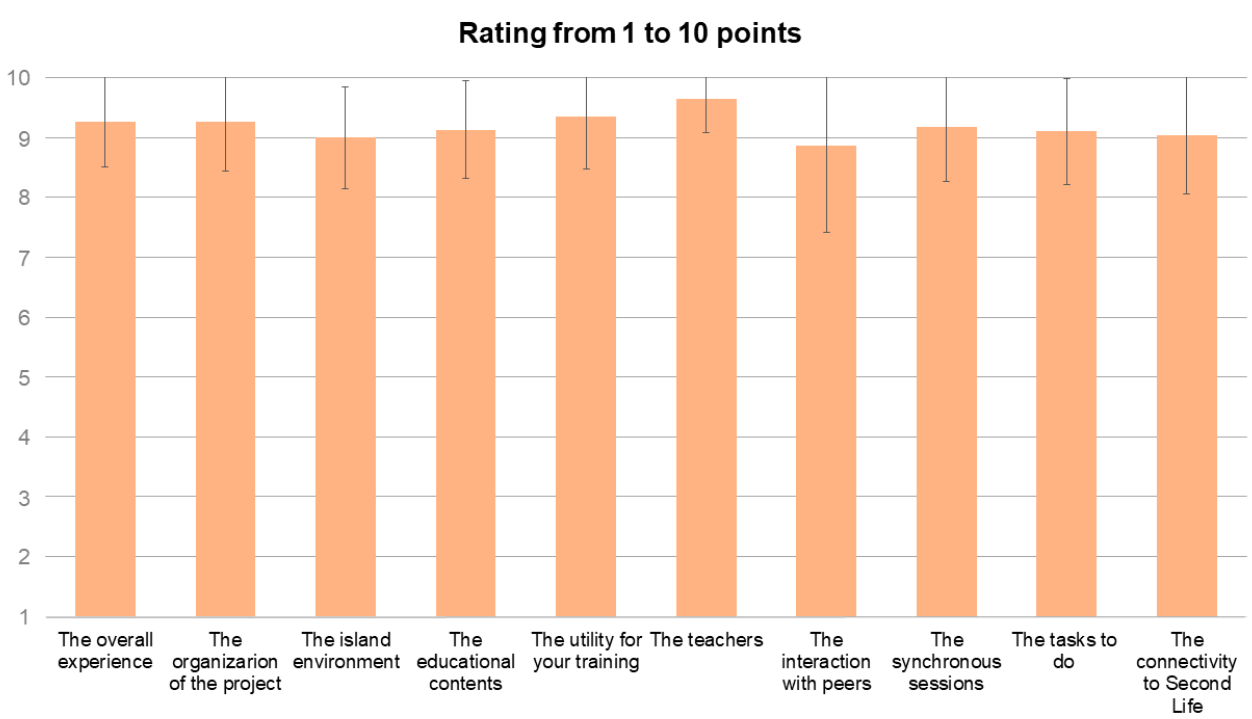
Figure 5. Rating bar graph from 1 to 10 points of various aspects of the experience. Data are mean values; error bars represent the standard deviation.